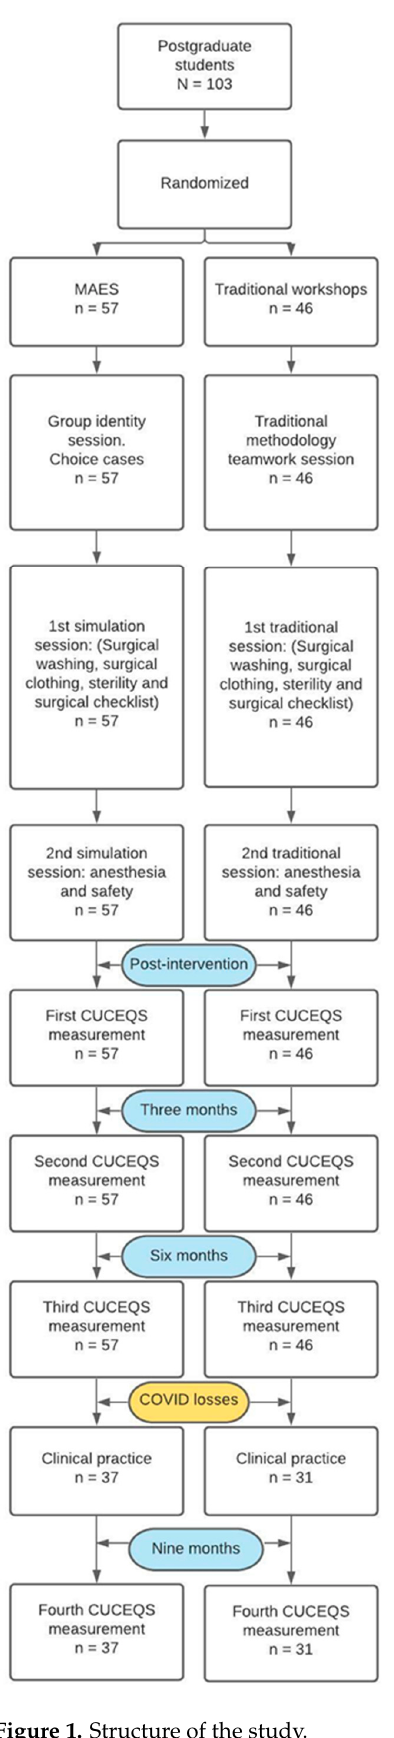
Figure 1. Structure of the